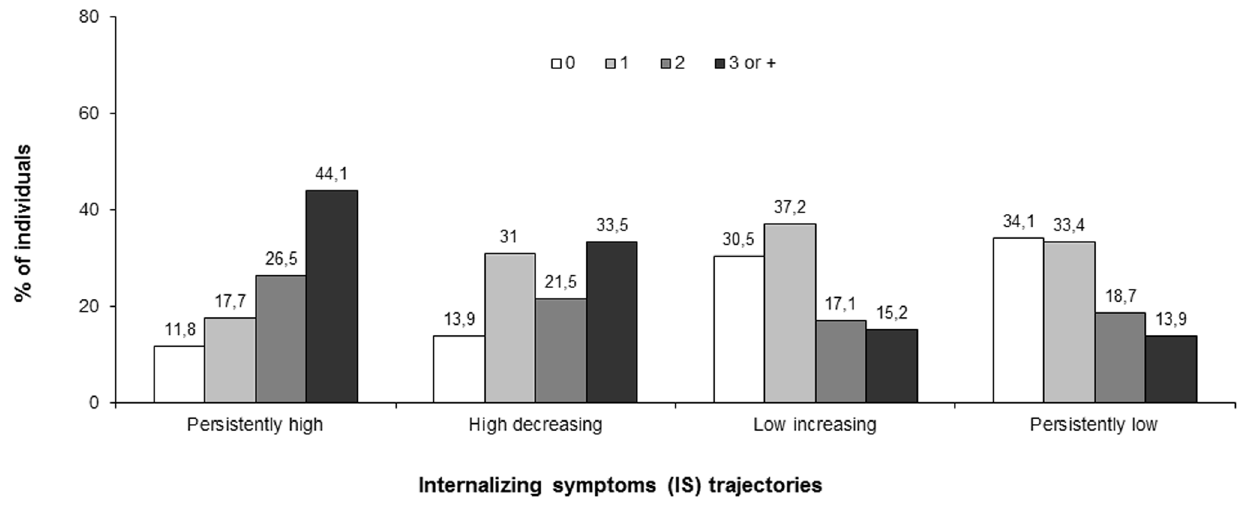
Figure 1. Number of childhood negative events and internalizing symptoms trajectories 1991–2009 (French TEMPO study, n 5 1503, %).